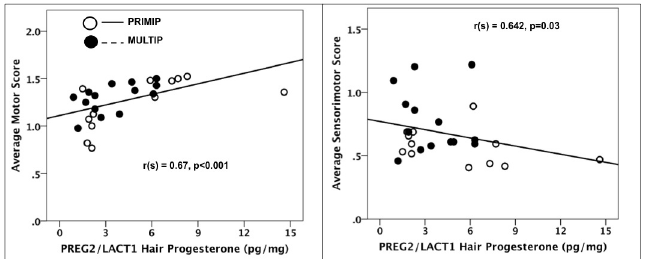
Fig 5. Associations between hair progesterone concentrations in late pregnancy/early lactation and infant neurobehavioral development. PRIMP = primiparous, MULTIP =